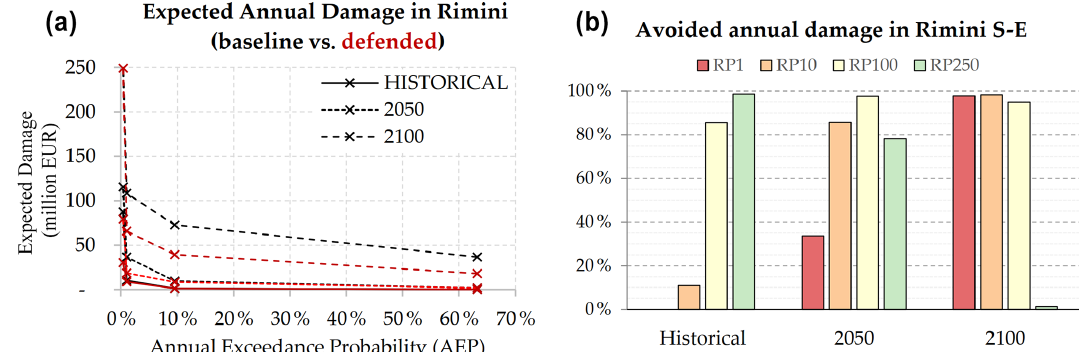
Figure 9. Rimini: expected annual damage (EAD) according to the undefended scenario up to 2100, all town considered (a) ; EAD reduction in the south-eastern part of the town thanks to hazard mitigation offered by the coastal barrier (b) .